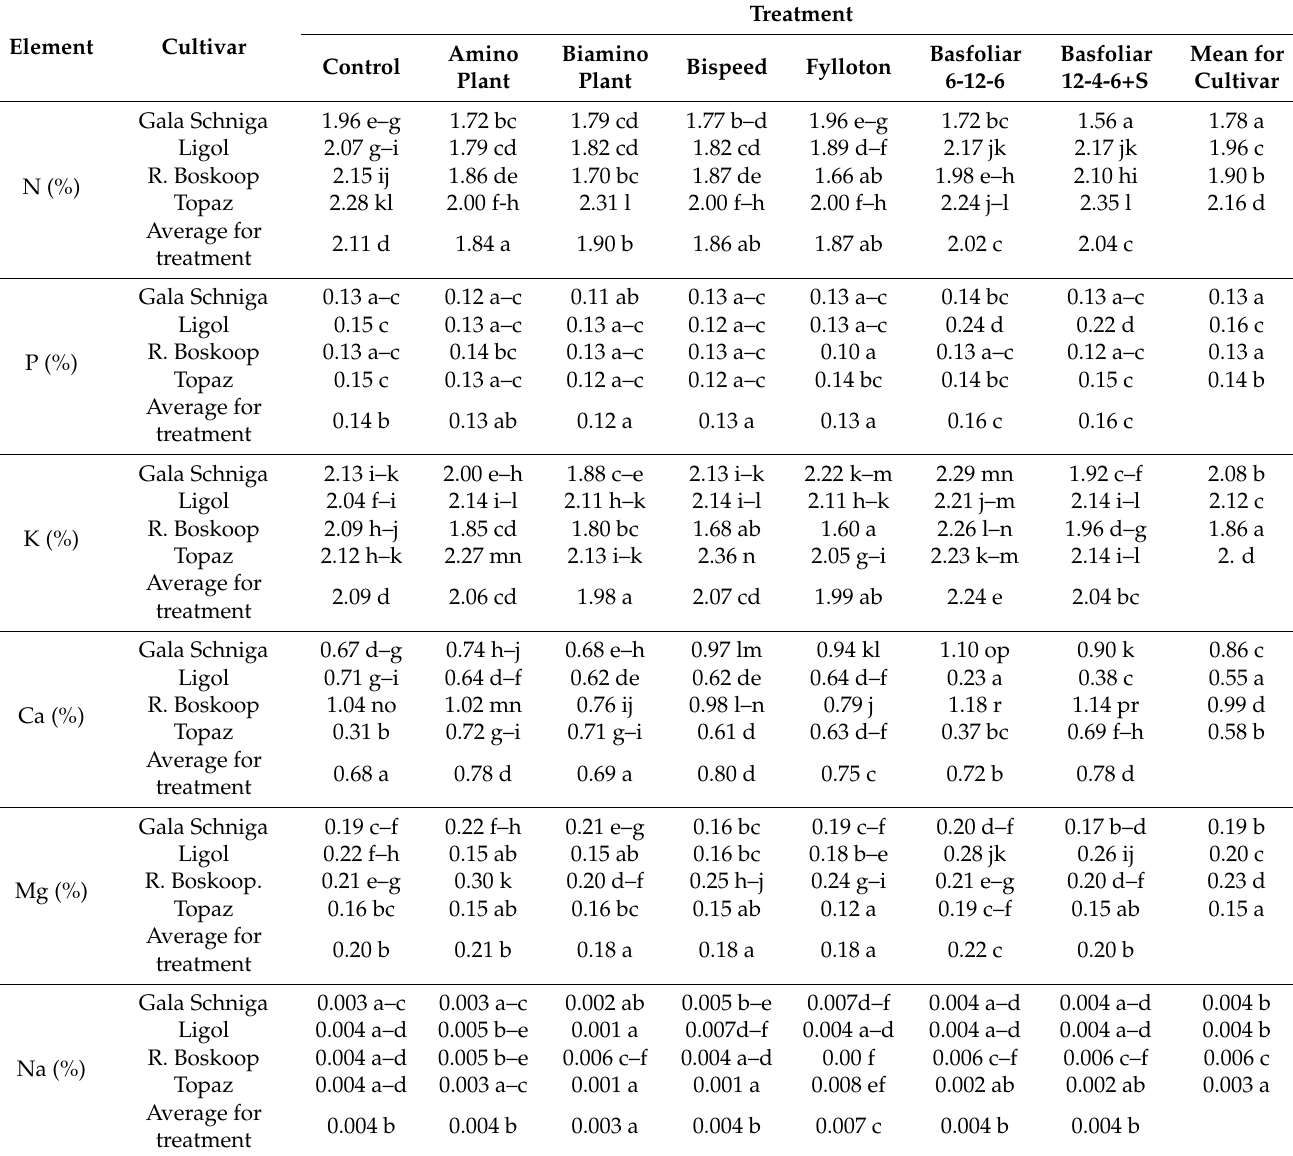
Table 4. The contents of macronutrients in the leaves of maiden apple